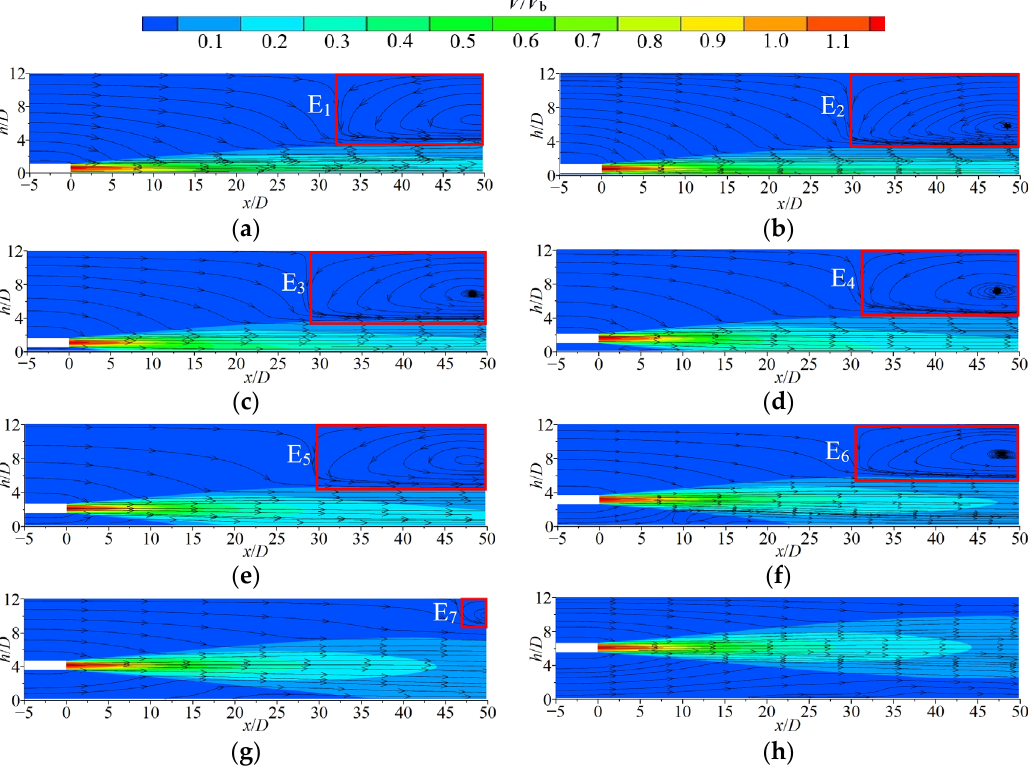
Figure 6. Contours with streamline diagrams of cross-sectional V / V b distribution ( oxz plane) in the jet under different H / D conditions: ( a ) H / D = 0.5; ( b ) H / D = 0.75; ( c ) H / D = 1; ( d ) H / D = 1.5; ( e ) H / D = 2; ( f ) H / D = 3; ( g ) H / D = 4; and ( h ) H / D = 6.